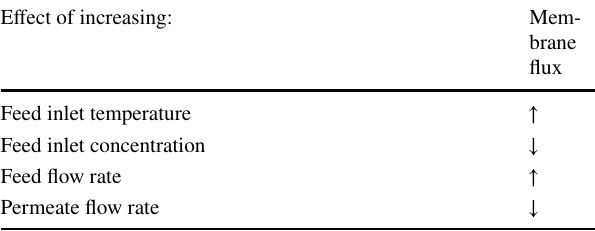
↑ denotes an increase, and ↓ denotes a decrease